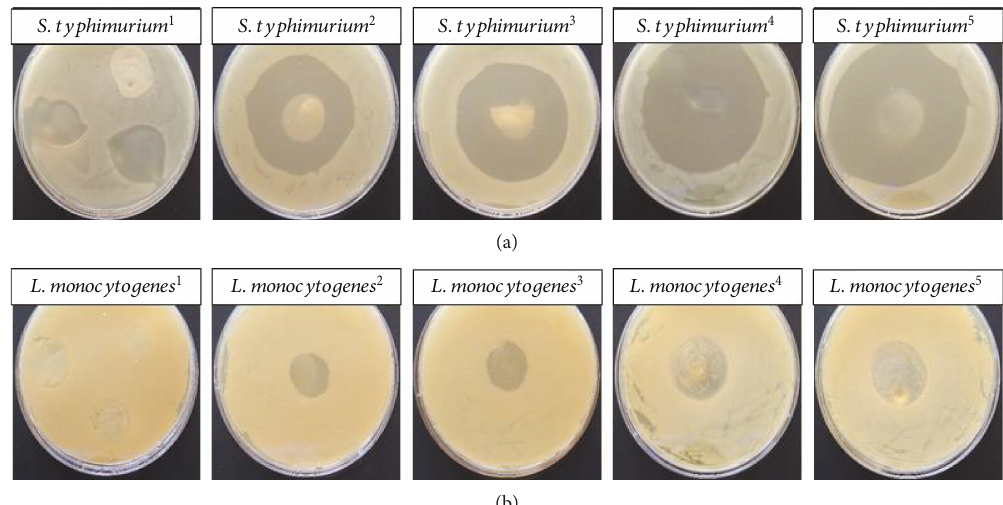
Figure 4: Images of inhibition zones of CEO-NE-alginate fi lms against (a) S. typhimurium and (b) L. monocytogenes , showing the largest and smallest halos, respectively, among tested bacteria. Films incorporating various CEO-NE concentrations were tested: (1) control, (2) CEO-NE 20%, (3) CEO-NE 25%, (4) CEO-NE 30%, and (5) CEO-NE